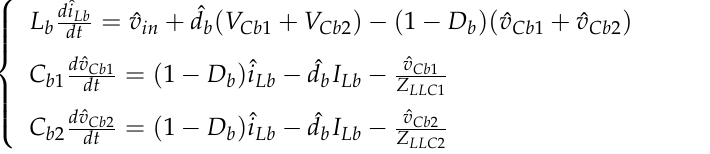
Figure 2. Equivalent circuit of interleaved Boost converter. The interleaved Boost converter works in PWM mode; Q 11 and Q 21 are only used as diodes, while Q 12 and Q 22 are interleaved with a phase difference of 180 degrees, and the state-space averaging method is used to conduct small-signal modeling [12]. The state equation of the small-signal model can be obtained as